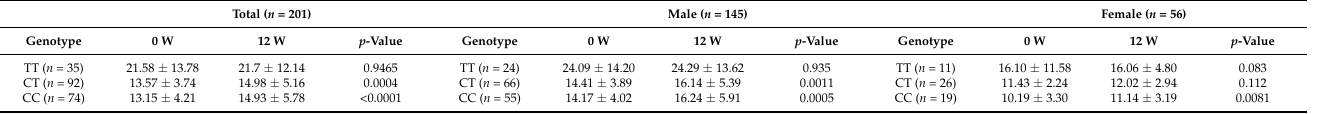
Table 3. The effect of MTX on serum homocysteine levels according to the genotype of MTHFR rs1801133 and gender.